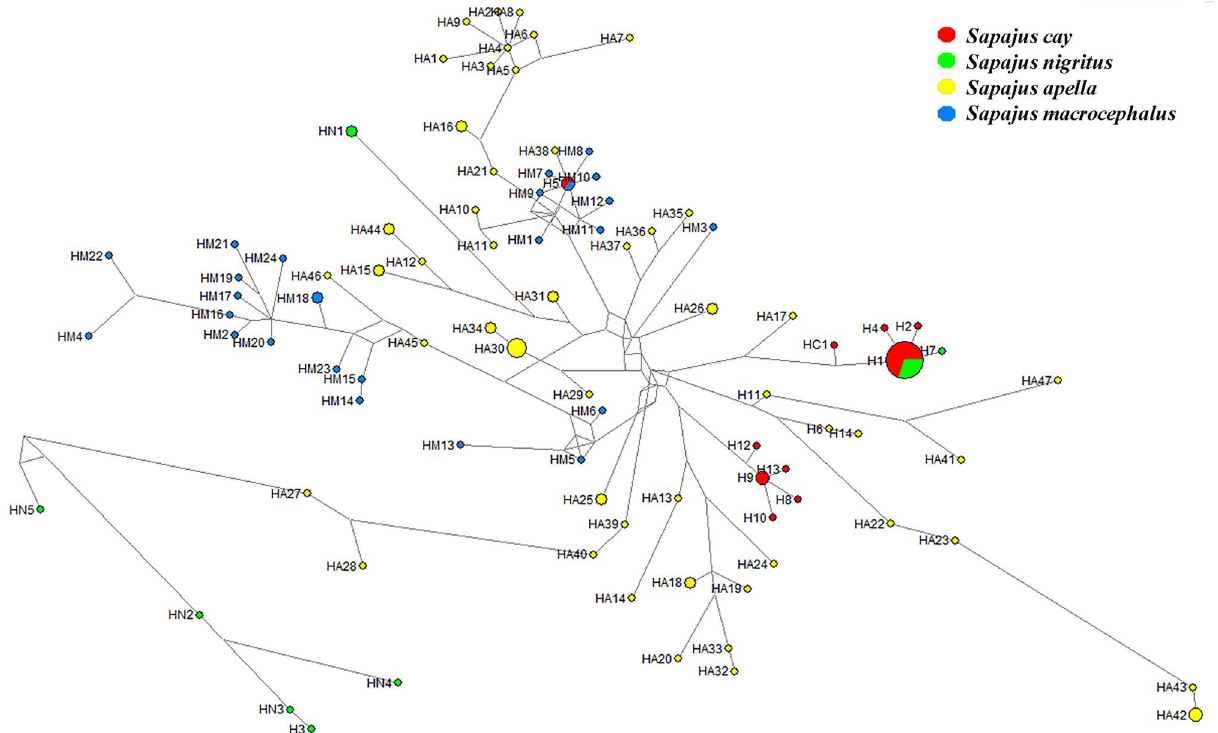
Figure 4. Median-joining haplotype network based on the 515 bp mtDNA-CR sequence from 36 specimens of S. nigritus and S. cay and published available sequences from these species and other nearby capuchin species, S. apella and S. macrocephalus (namely HC1 for S. cay , HN1-HN5 for S. nigritus , HA1-HA45 for S. apella and HM1-HM24 for S. macrocephalus see “Material and methods” section). The size of the circles (haplotypes) is proportional to the number of specimens sharing a given haplotype. Branches are proportional to the mutation number. Sapajus cay individuals’ haplotypes are represented in red, S. nigritus ones in green, S. apella in yellow, and S. macrocephalus in